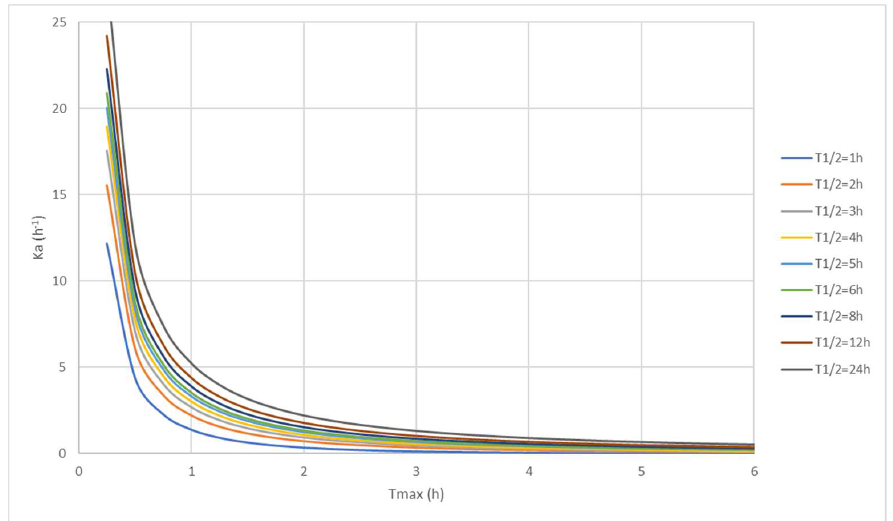
Figure 6. Influence of variations in t max (h) and in t 1/2 (h −1 ) on the estimation of k a . Small variations in t max have greater impact on k a than variations in t 1/2 , especially when t max value are small. As whole, from 54 DDI studies leading to a MAT ratio >1.30 or <0.77, only 33 of them had a MAT ratio unaffected (i.e., always remaining >1.30 or <0.77) by variations of ±10% in t max , and were thus considered as potentially resulting from a variation in the absorption rate. The magnitude of the effect of a DDI on the absorption rate of a drug (estimated by MAT ratio) appeared related to the Fabs of the drugs (Figure 7).